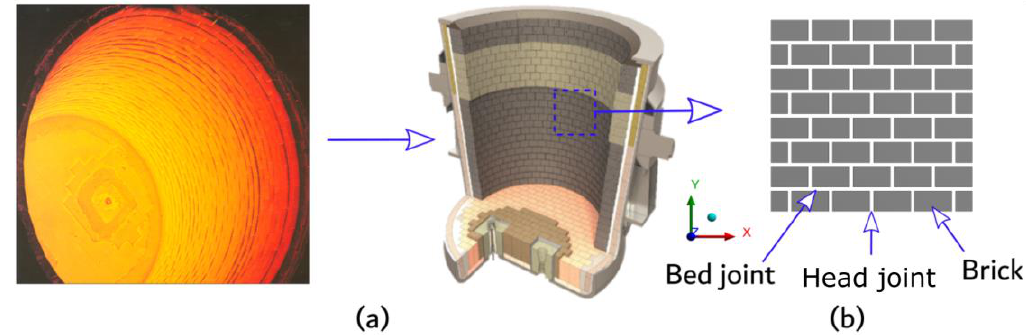
Figure 2. Steel ladle lined with dry-stack refractory masonry: ( a ) Section view and ( b ) schematic of dry-stack masonry structure.